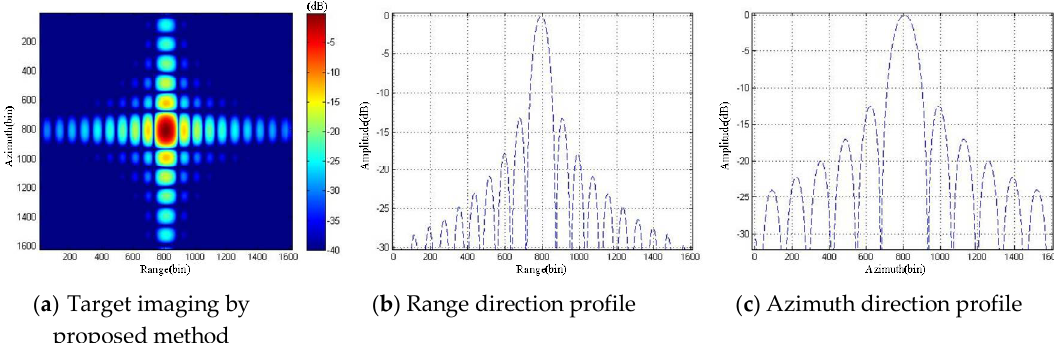
Figure 24. Imaging simulation results of the strong scattering target by proposed method. Table 3. The quality parameters of the strong scattering target imaging result.